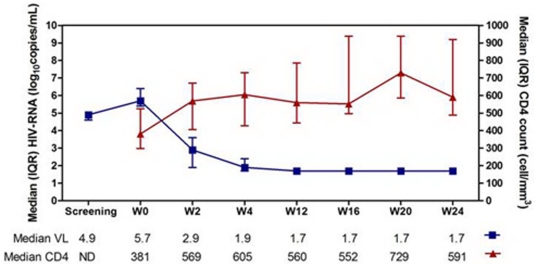
Plasma HIV RNA and CD4 response to megaHAART.The mean time from the screening visit to week 0 is 3 days (standard deviation 1.6 days).